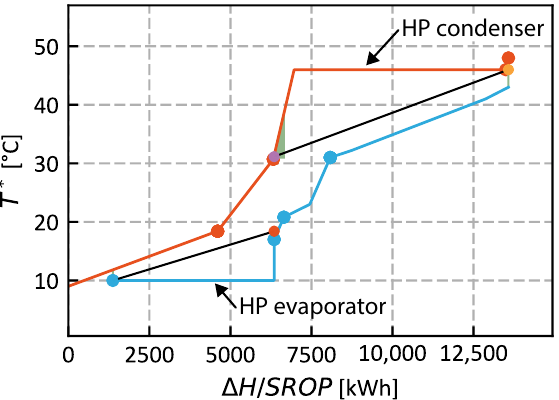
Figure 16. ISSPwith the integrated HP streams for the industry case study. The HP potential of the obtained solution in terms of condenser capacity is approx- imately 6500 kWh/day. The resulting ISSP with the HPTES solution contains two ILs. Figure 17 shows the schematics of the combined IHR and HPTES system (Variant 4).